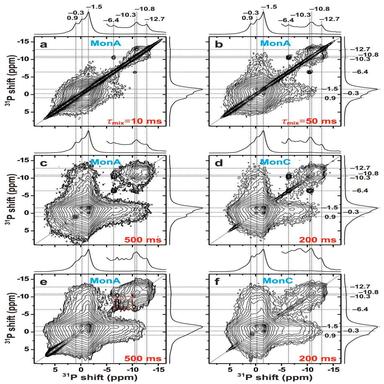
1Q–1Q correlation 31P NMR spectra recorded at 7.00 kHz MAS from the (a–c, e) MonA and (d, f) MonC cements for the as-indicated mixing periods (τmix). Projections along each spectral dimension are shown to the right and at the top (with insets of vertical expansions of the NMR intensities across the "pyrophosphate region") of the 2D spectrum. The 31P magnetization exchange in the NMR experiments in (c–f) is driven mainly by residual 1 H–31P dipolar interactions and 1 H spin diffusion